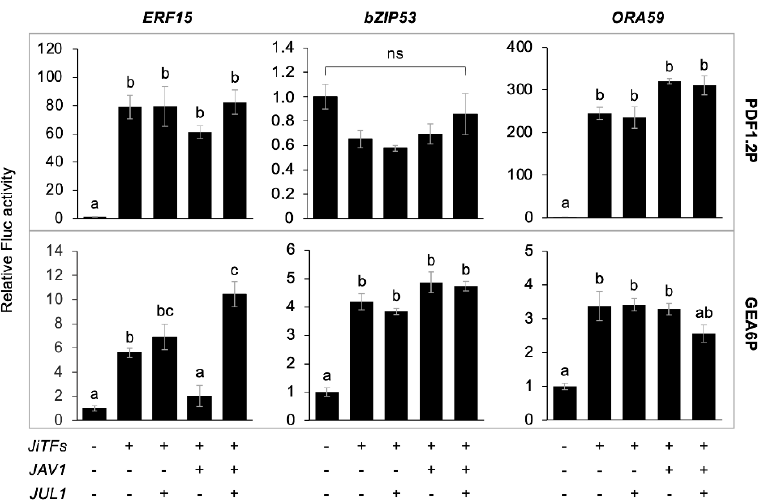
Figure 3. Modulation of JiTF1-mediated PDF1.2 promoter (PDF1.2P) and GEA6 promoter (GEA6P) activities via JAV1/JUL1. Transient activation of a firefly luciferase ( Fluc ) reporter gene under the control of PDF1.2P and GEA6P following expression with (+) or without ( − ) JiTFs ( JiTF3 [ ERF15 ], JiTF5 [ bZIP5 ] and JiTF7 [ORA59]), JAV1 or JUL1 in Arabidopsis thaliana protoplasts. Data represent the mean and standard error ( n = 5). The means indicated by different small letters are significantly different among data of each day, based on an ANOVA with post hoc Tukey’s HSD ( p < 0.05). ns, not significant.